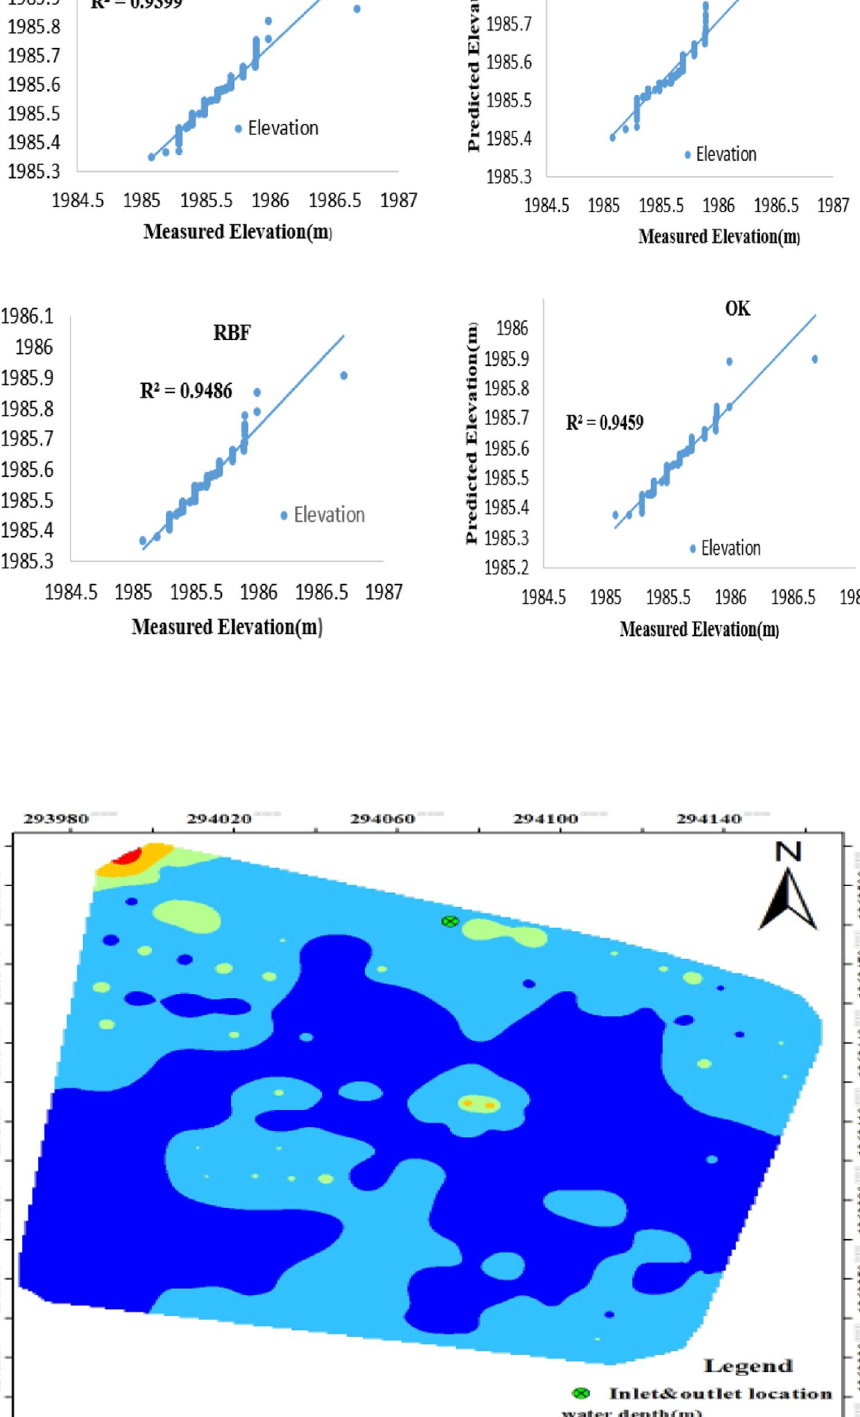
Fig. 7 Predicted VS measured bed elevation of Adebra NSR test dataset